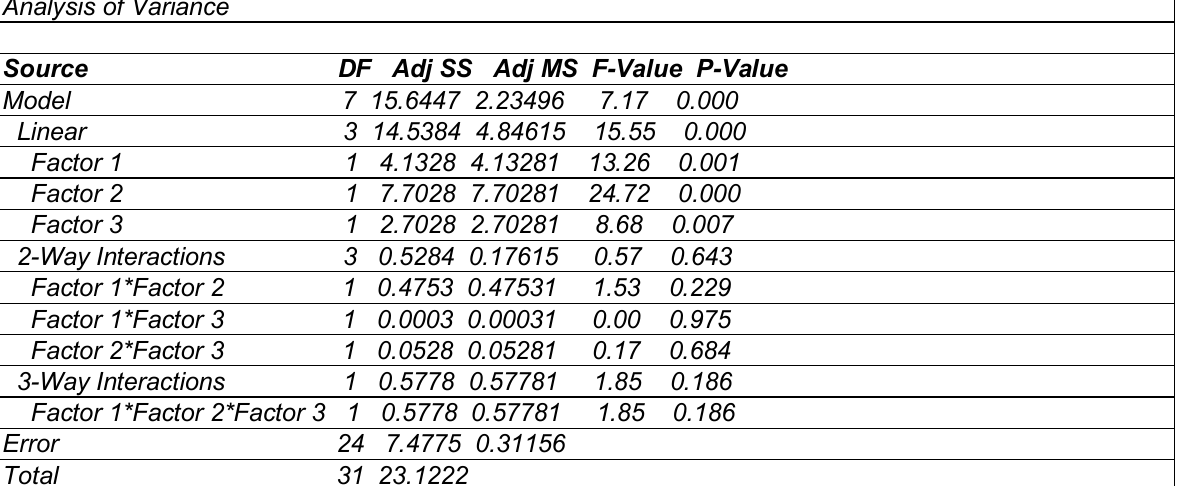
Table 5: ANOVA Results